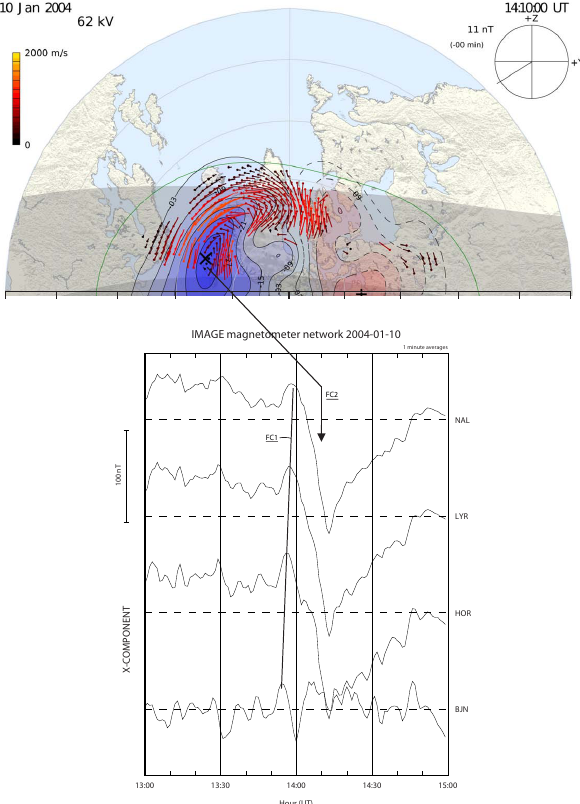
Fig. 7. SuperDARN convection plot for 14:10UT (top) and ground magnetic deflections from Svalbard IMAGE stations NAL (75 ◦ MLAT), LYR (74 ◦ MLAT), HOR (73 ◦ MLAT) and BJN (71 ◦ MLAT) during the interval 13:00–15:00UT. Magnetic signa- tures of enhanced flows in flow channels FC 1 and FC 2 are marked. The coordinate system in the upper panel is MLAT/MLT. The sun is at the top and dusk is to the left. MLAT range from 40–90 ◦ is